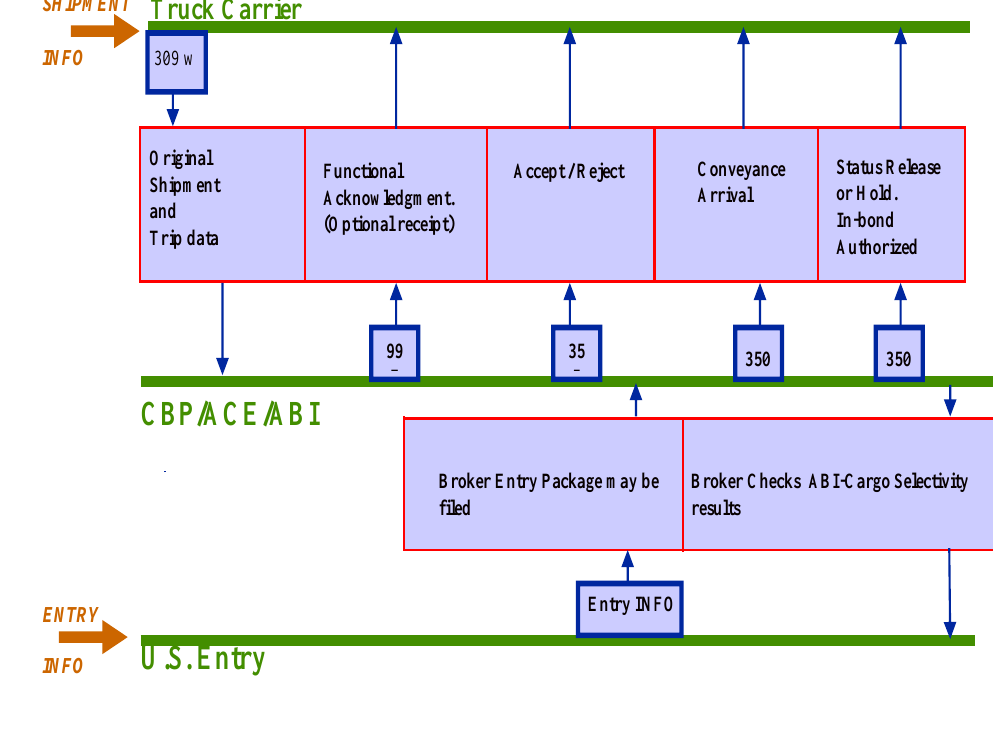
Figure 9. Communication through the